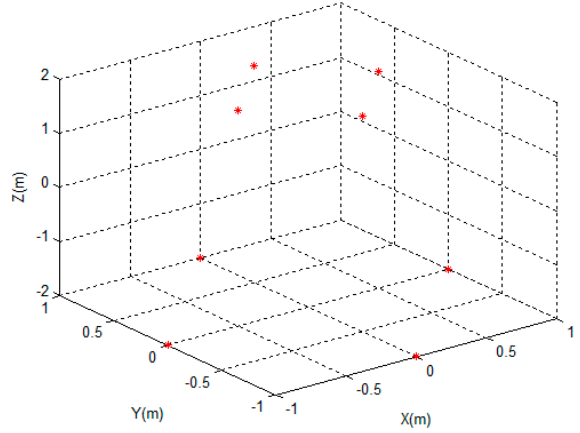
Figure 4. The distribution of the scattering centers.